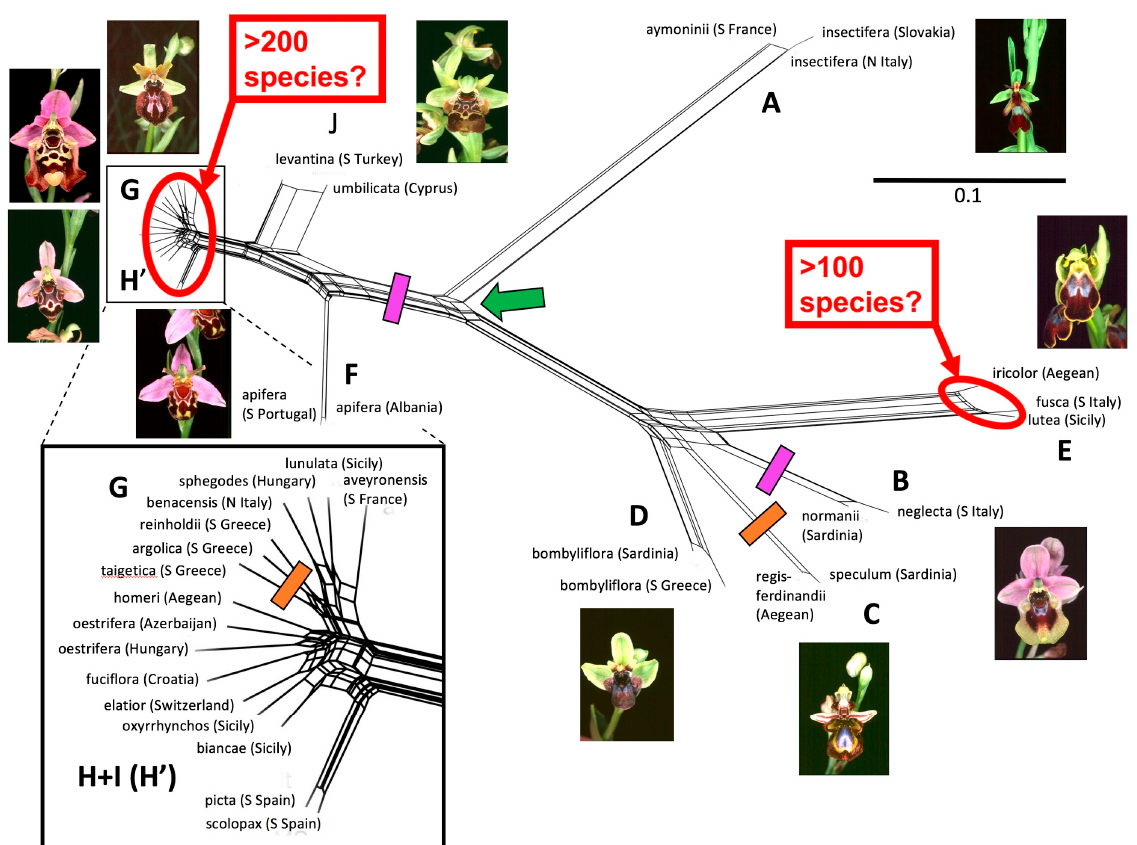
Figure 1. Unrooted SplitsTree network based on 4059 RAD-seq-derived single nucleotide polymor- phisms (SNPs) for 32 plants that together represent the nine Ophrys macrospecies ( A – H’ , J ) circum- scribed by Bateman et al. [43]. Inset: Magnified view of that portion of the topology that represents groups G and H’. The root of the tree remains equivocal but certainly lies close to the green-arrowed node. Red ovals emphasise the poverty of genetic variation present in the microspecies-rich groups E, G and H’. Pink bars indicate two predicted origins of the ability to infuse sepals and petals with pink–purple anthocyanin pigments; brown bars indicate two predicted origins of the ability to gen- erate longitudinal stripes of red–brown pigment on the lateral sepals.